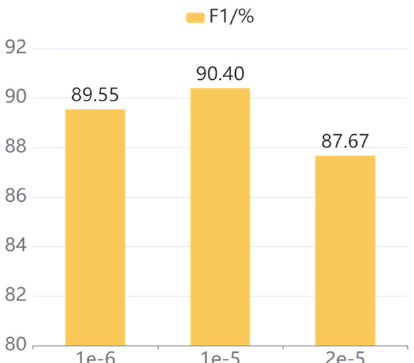
Figure 7. Comparison results for different learning rates on CCKS2019.